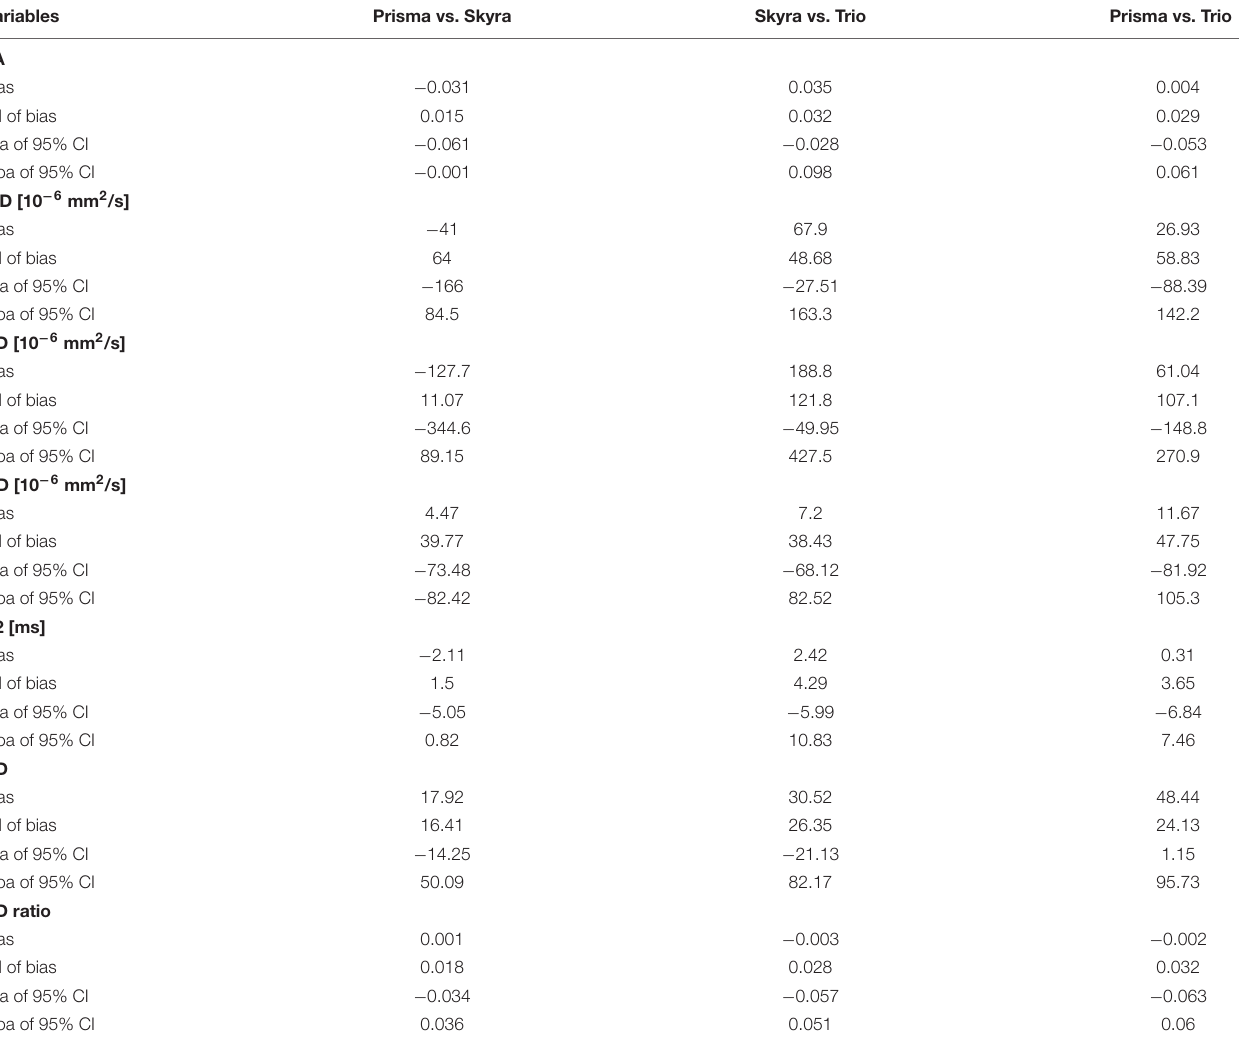
TABLE 3 | Bland-Altman analyses for inter-scanner agreement.